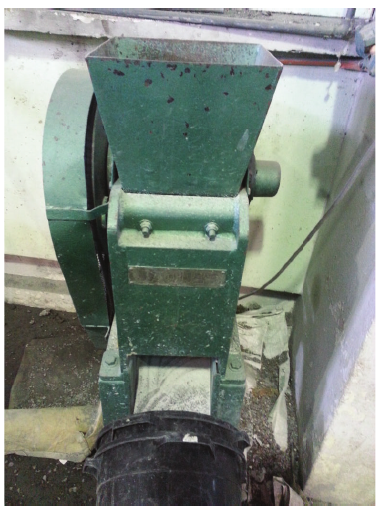
Figure 2: Stone-crushing machine for OPS aggregates.